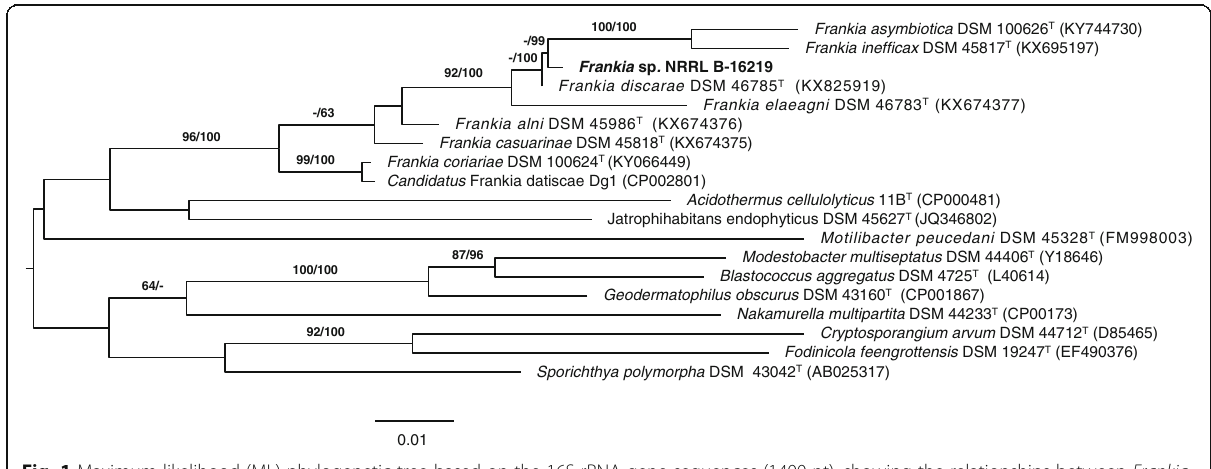
Fig. 1 Maximum likelihood (ML) phylogenetic tree based on the 16S rRNA gene sequences (1400 nt), showing the relationships between Frankia NRRL B-16219 and Frankia species. The ML tree was inferred using the GTR + GAMMA model and rooted by midpoint-rooting; the branches are scaled in terms of the expected number of substitutions per site. The numbers above the branches are support values when larger than 60% from ML ( left ) and MP ( right )